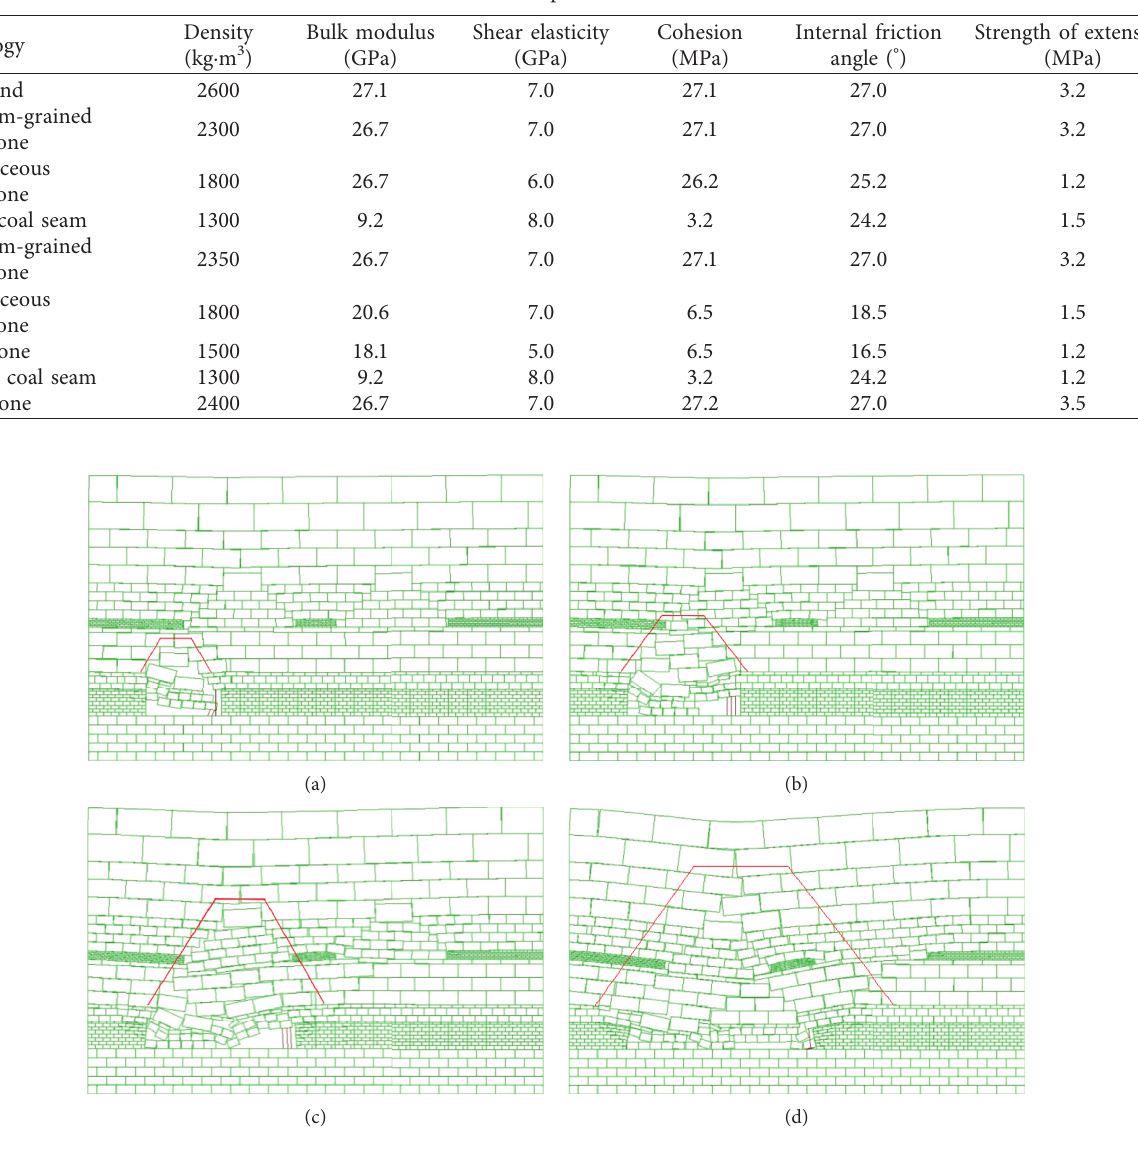
Figure 1: Initial design model Table 1: The mechanical parameters of rock masses.